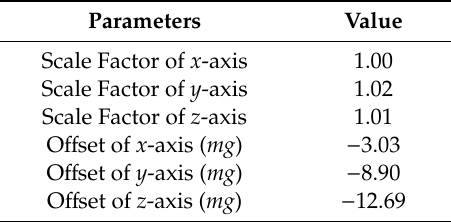
Table 8. The parameters of the six-parameter